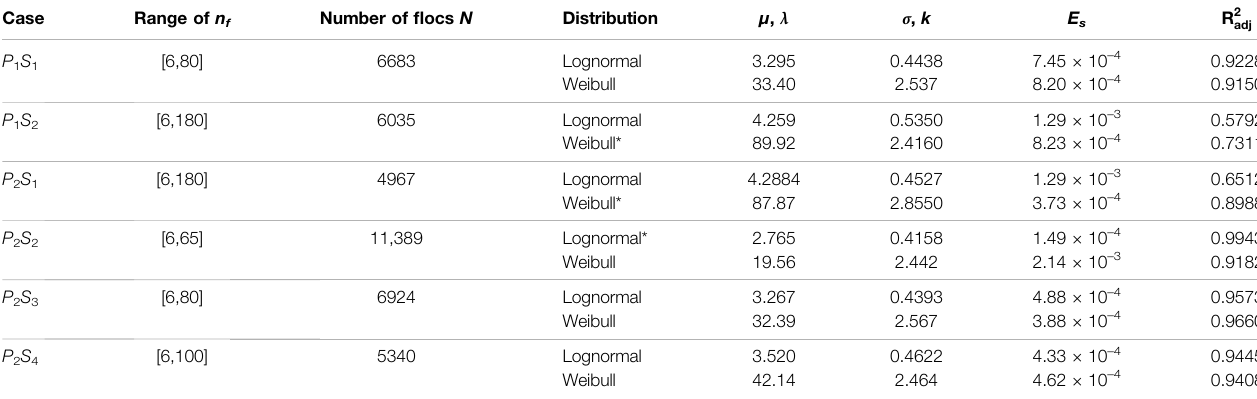
TABLE 2 | Anderson – Darling test results and the adjusted coef fi cient of determination R 2 adj . Case Range of n